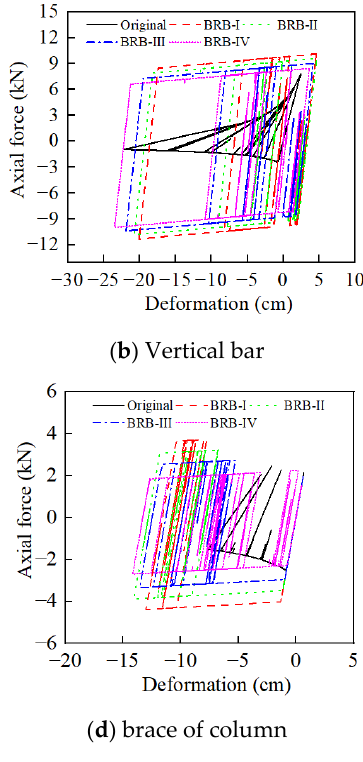
Figure 12. Hysteresis curves of braces.